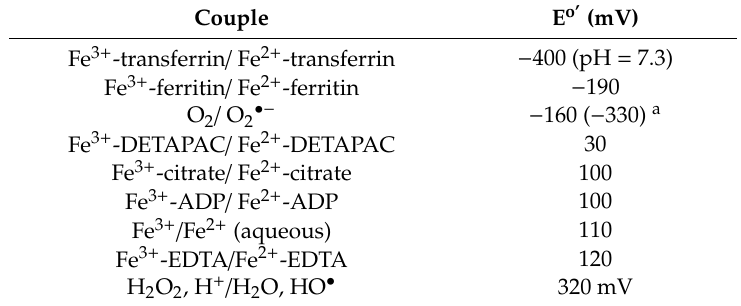
Table 1. Standard one-electron reduction potentials involving iron complexes at pH = 7.0 [133]. Couple E o’ (mV) Fe 3 + -transferrin / Fe 2 + -transferrin − 400 (pH =